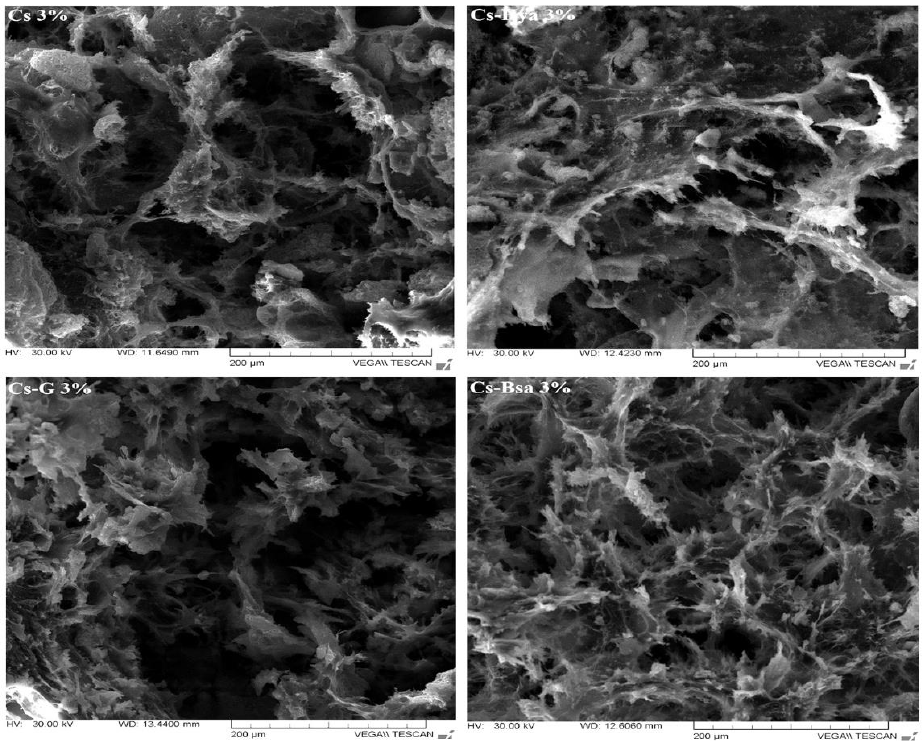
Figure 8. SEM images obtained for scaffolds made from [CS], [CS/HyA], [CS/G], and [CS/BSA] with a concentration of 3% MNPs [87]. Reprinted from [87], Copyright (2023), with permission from